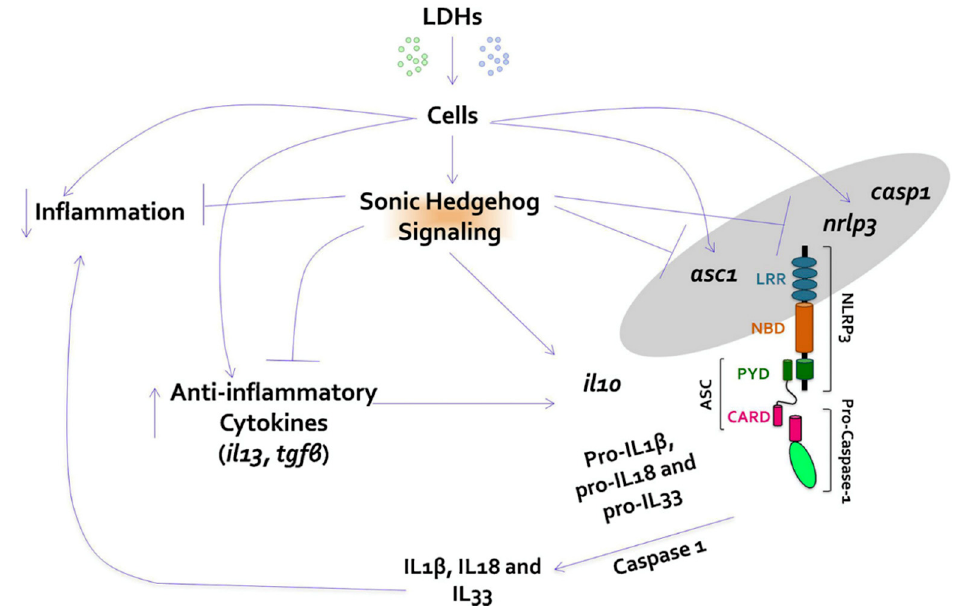
Figure 14. Role of LDHs in inducing the anti-inflammatory Sonic hedgehog acute inflammatory molecular pathway. Reprinted from Ref. [216], Copyright (2019), with permission from Elsevier.